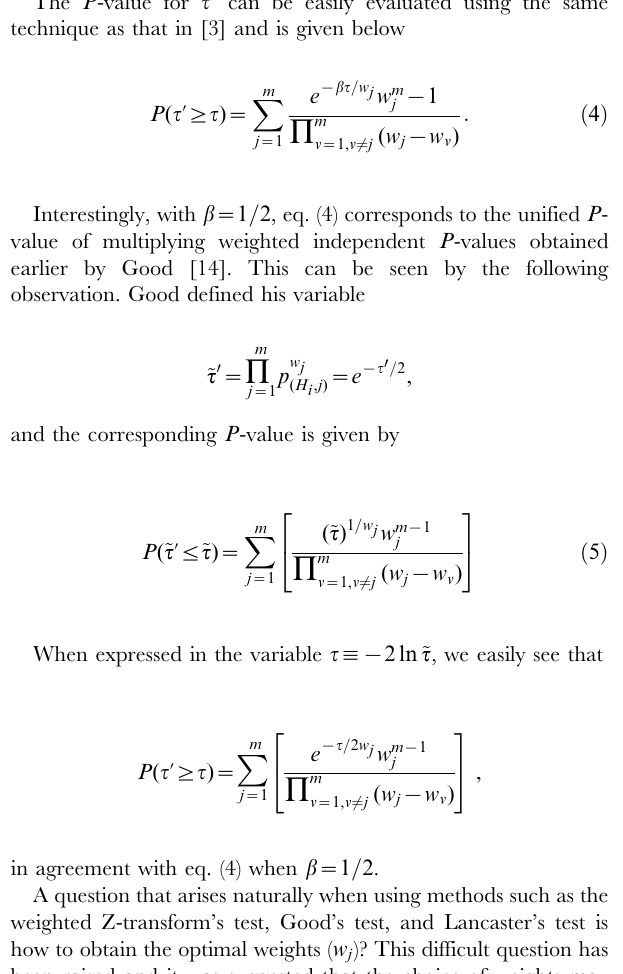
ffiffiffiffiffiffiffiffiffiffiffiffiffiffiffiffiffiffi P m q w 2 j j ~ 1